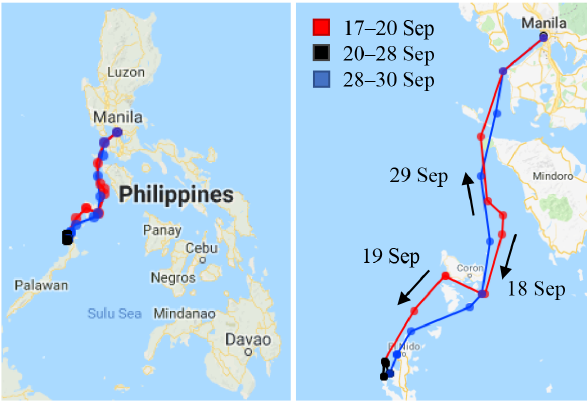
Figure 1. Path taken by the M/Y Vasco on 17–20 September (red), 20–28 September (black), and 28–30 September (blue). The ma- jority of sampling was done at the northern end of Palawan island. Image courtesy of Google Maps (map data ©2018